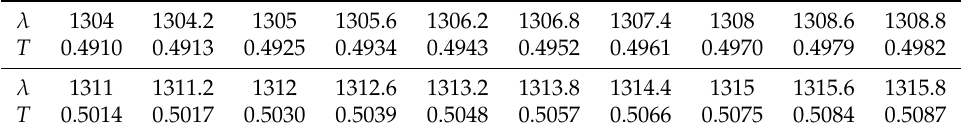
Table 3. The transmittance T at different wavelengths of 50:50 BS with a center wavelength of 1310